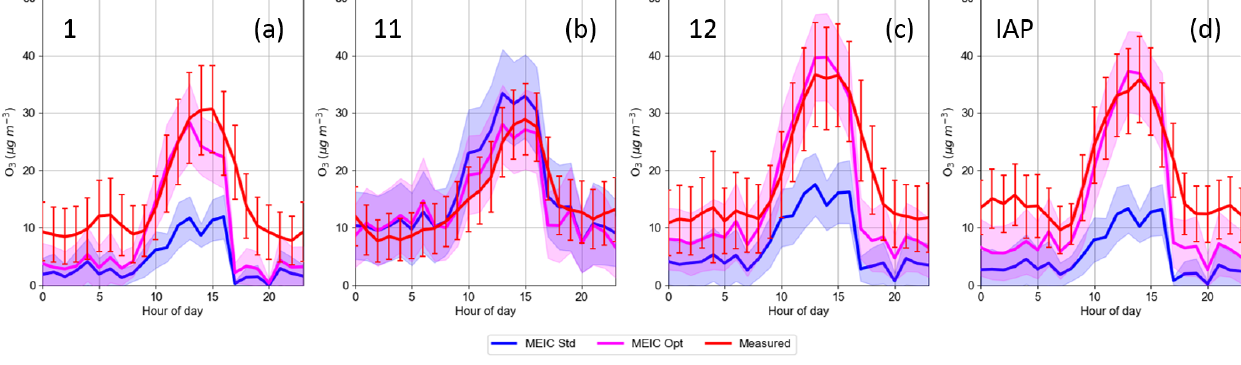
Figure 12. Campaign period mean diurnal variation in modelled and measured O 3 concentrations at sites (a) 1, (b) 11, (c) 12 and (d) IAP. Modelled concentrations produced using both MEIC Std (blue) and MEIC Opt (pink). Measurements marked by red line. Shaded areas and error bars represent the 95% confidence intervals for simulated and measured concentrations,